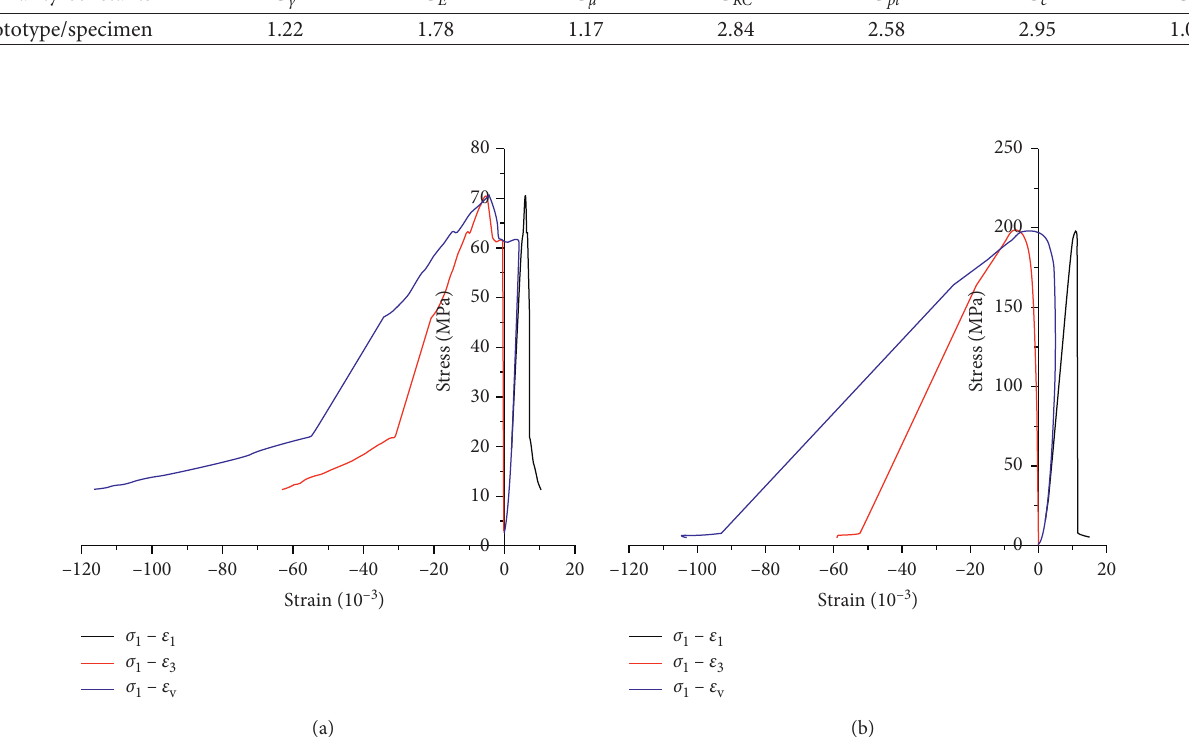
Figure 2: The stress-strain curves of rock-like specimen and marble specimen. (a) Rock-like specimen. (b) Marble